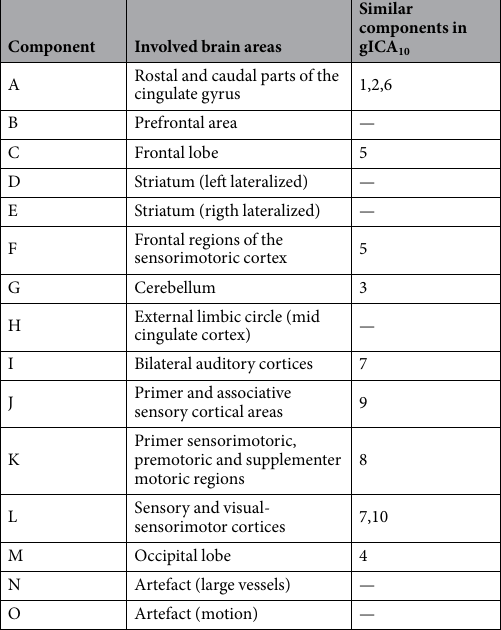
— Table 1. Spatial topography of ICA models at model orders of 15 and 10, listing the most characteristic brain regions. Capital letters refer to components from gICA 15 , while the numbers refer to components from the gICA 10 . Similarity is based on the involved brain regions and visual